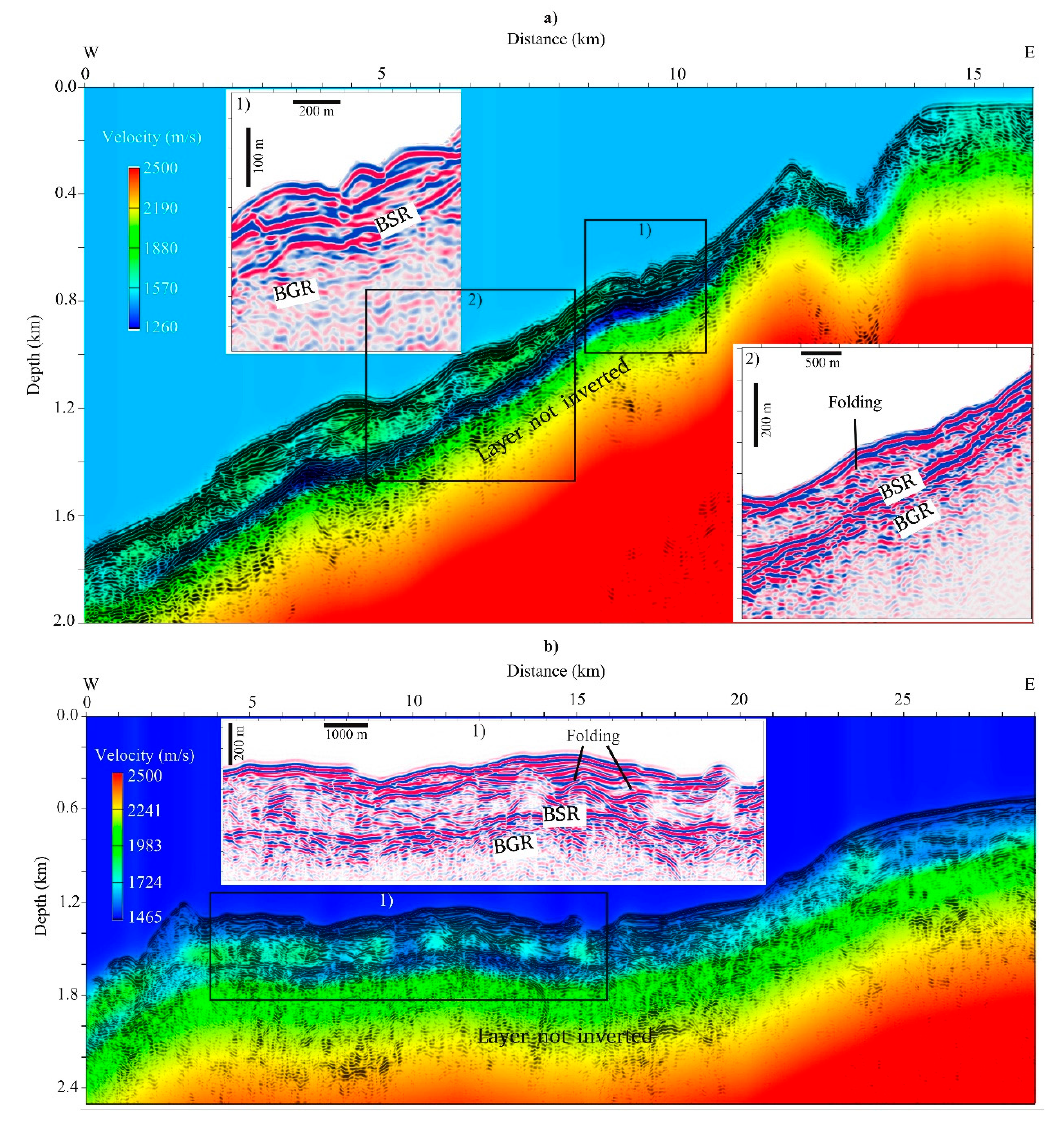
Figure 2. Pre-stack depth sections with superimposed velocity models. In ( a ) SO161–35 seismic section; and ( b ) RC2901–731 seismic section. Black boxes indicated with numbers show the blow-ups.